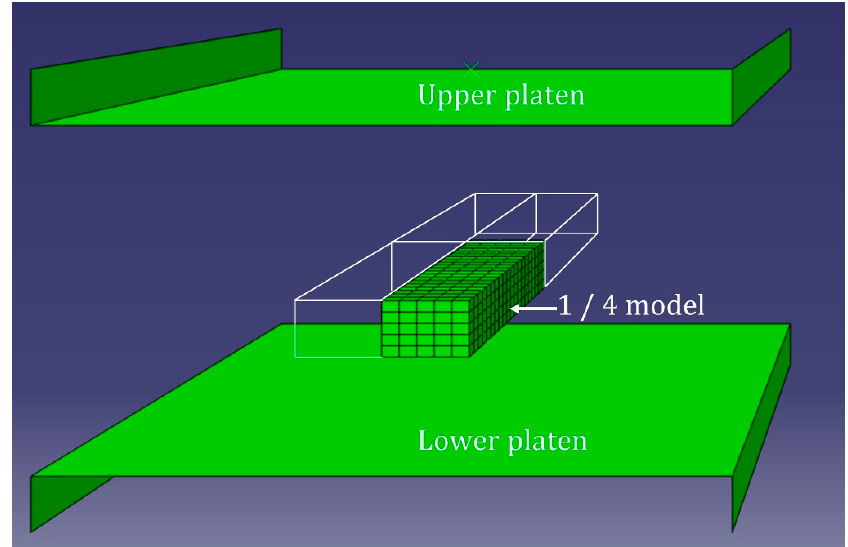
Figure 12. Finite element simulation model of compression of rectangle specimen.